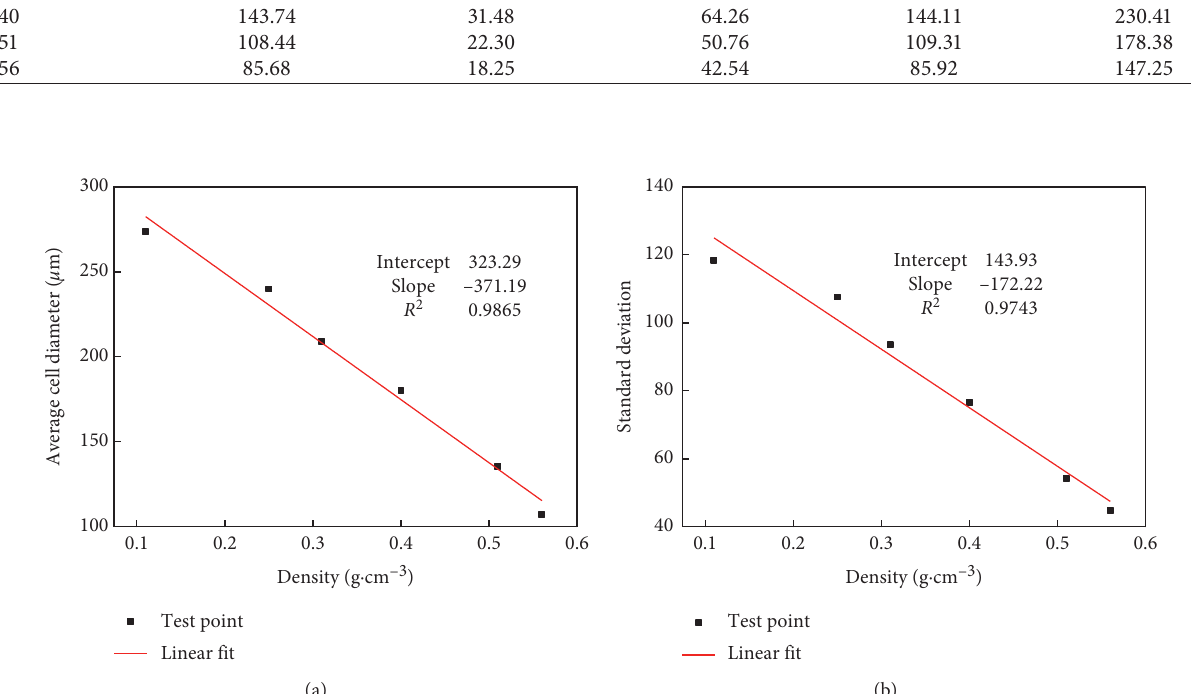
Figure 8: Relationship between cell diameter and density. (a) Relationship between average cell diameter and density; (b) relationship between standard deviation and density.